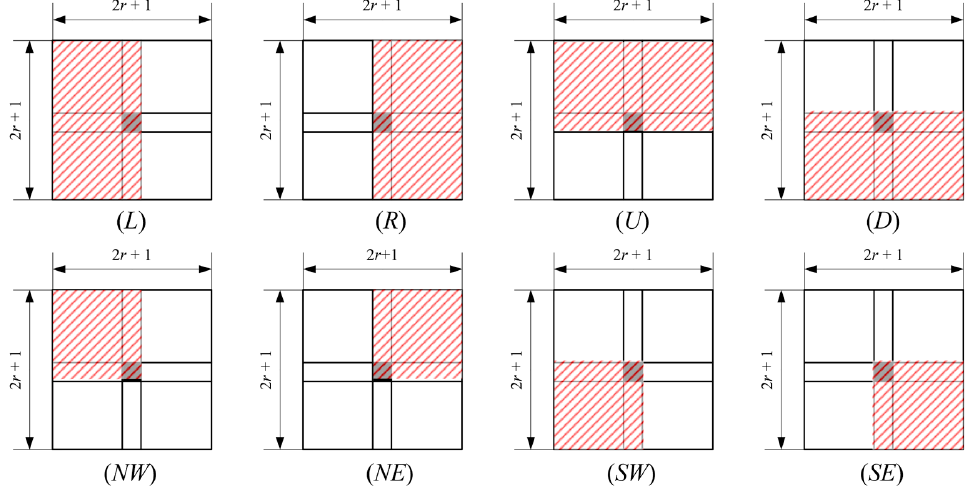
Figure 10. Definition of side window core.